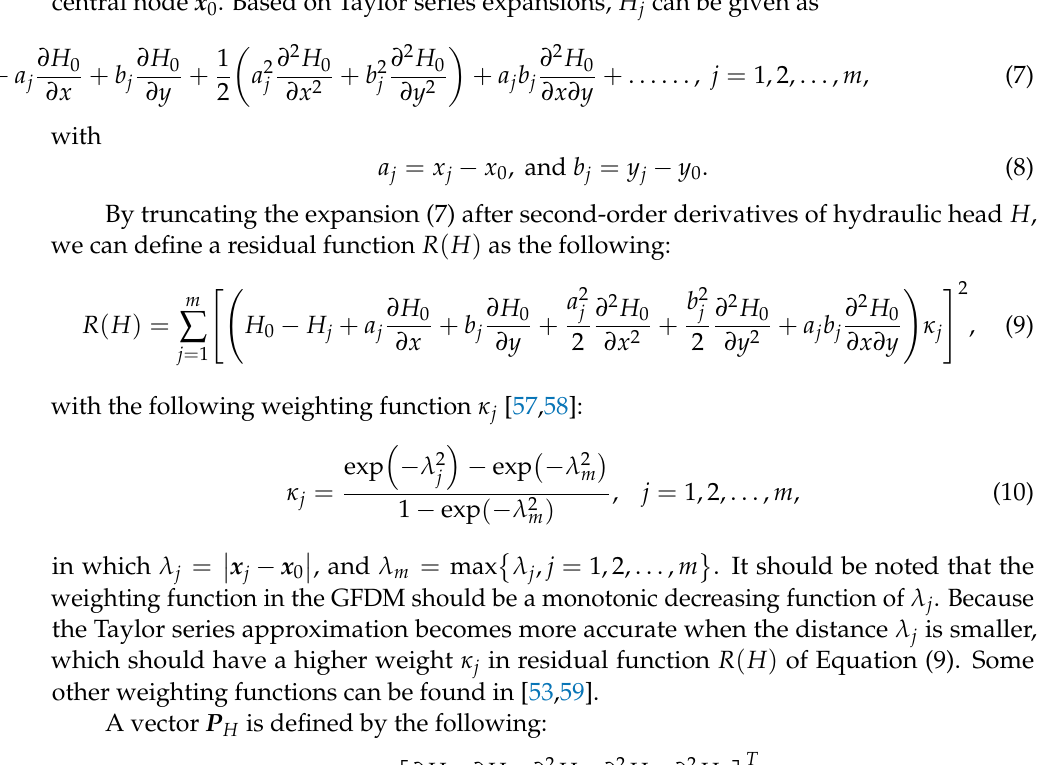
Figure 1. A star of collocation node